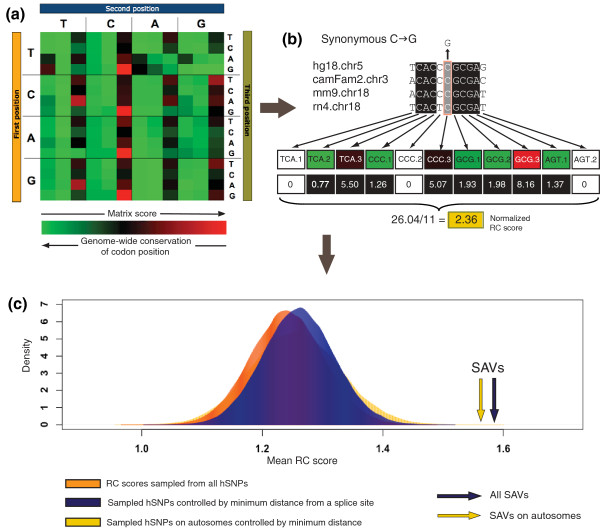
Regions surrounding SAVs are under greater non-coding evolutionary constraint. (a) We created a 192-codon position-specific scoring matrix based on genome-wide conservation levels across mammals. Matrix scores are visualized increasing from green to red. As scores are inversely proportional to the genome-wide conservation of each codon position, conservation levels can also be visualized using the same matrix, decreasing from green to red. (b) For each variant, four-way mammalian multiple DNA alignments were extracted for a region surrounding the variant, and a score assigned to each fully conserved column via the scoring matrix, and the total normalized by the length of the alignment. An example of a random synonymous CγG variant is shown. (c) The mean conservation score for all SAVs (blue arrow) and SAVs on autosomes (yellow arrow) was compared to a distribution of randomly sampled sets of scores from all hSNPs (orange distribution). Randomly sampled distributions of hSNPs were also created controlling for minimum distance from a splice junction by having similar distributions in this regard as SAVs (blue distribution). A distribution of mean conservation scores was also produced for hSNPs from autosomes also controlled by minimum distance from the splice site (yellow distribution).